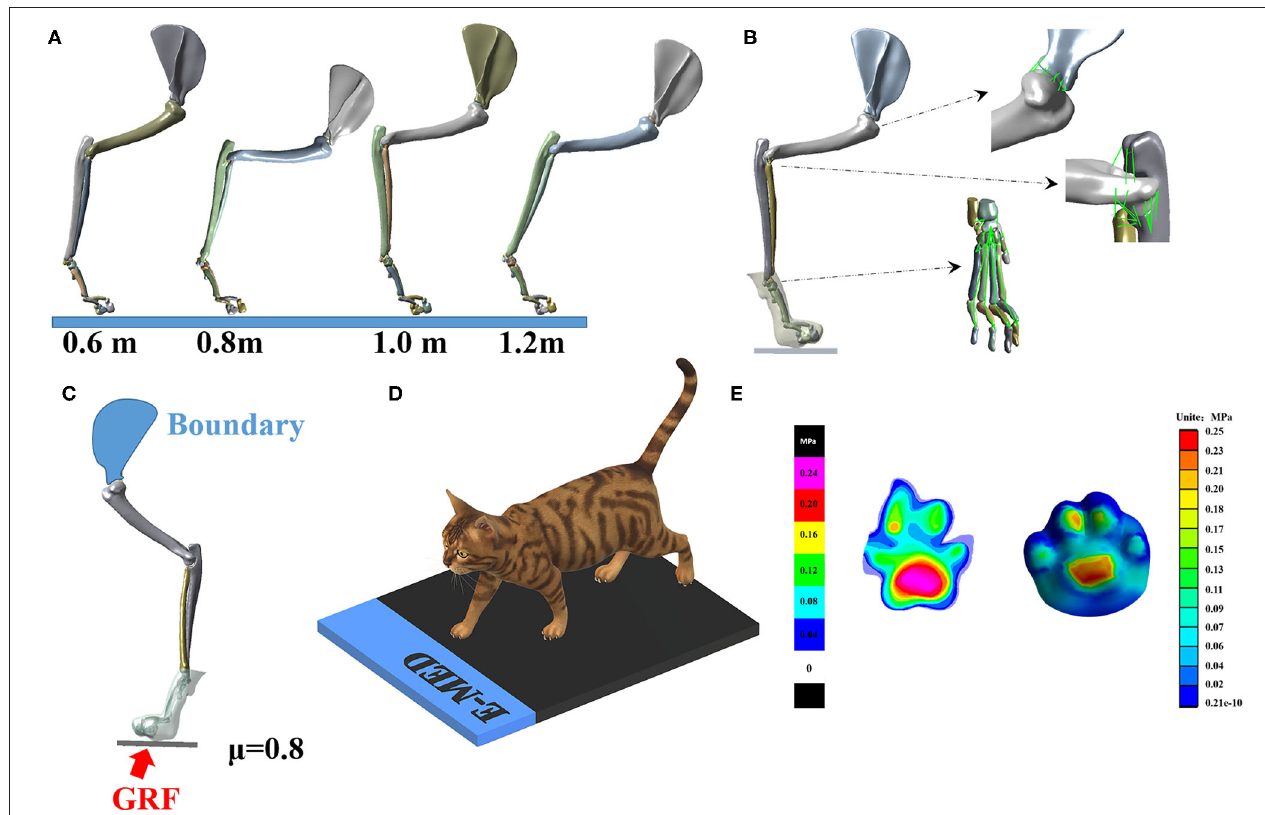
FIGURE 2 | (A) Finite element 3D model of right forelimb at four landing heights. (B) Illustration of ligament and soft tissue of model. (C) Illustration of loading and boundary conditions. (D) Experimental verification of plantar pressure of cat right forelimbs. (E) Experimental verification results (left) and finite element simulation results (right). The scales on the left and right diagrams are different; please refer to their scales.